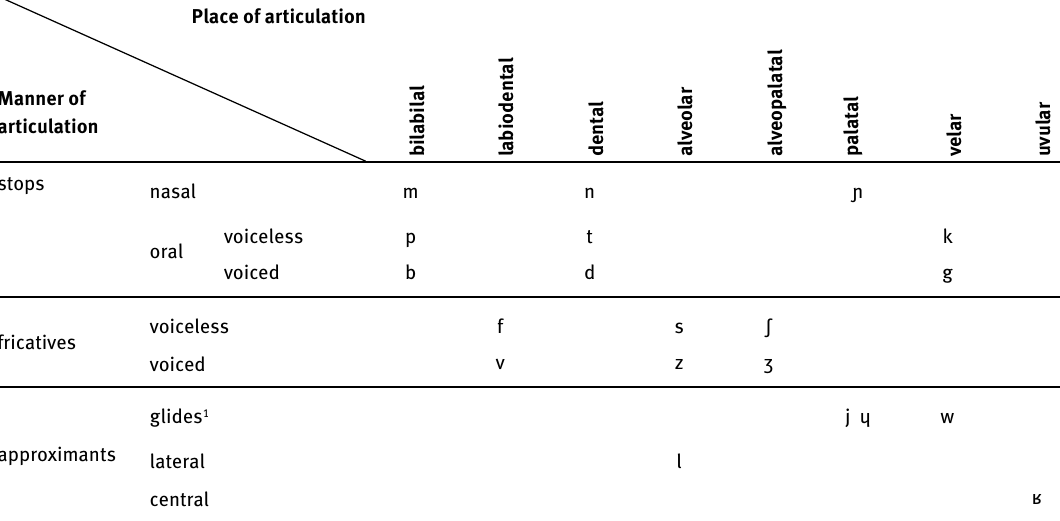
Table 1. French consonant inventory (Bernard Tranel, 1987: 126)1 Place of